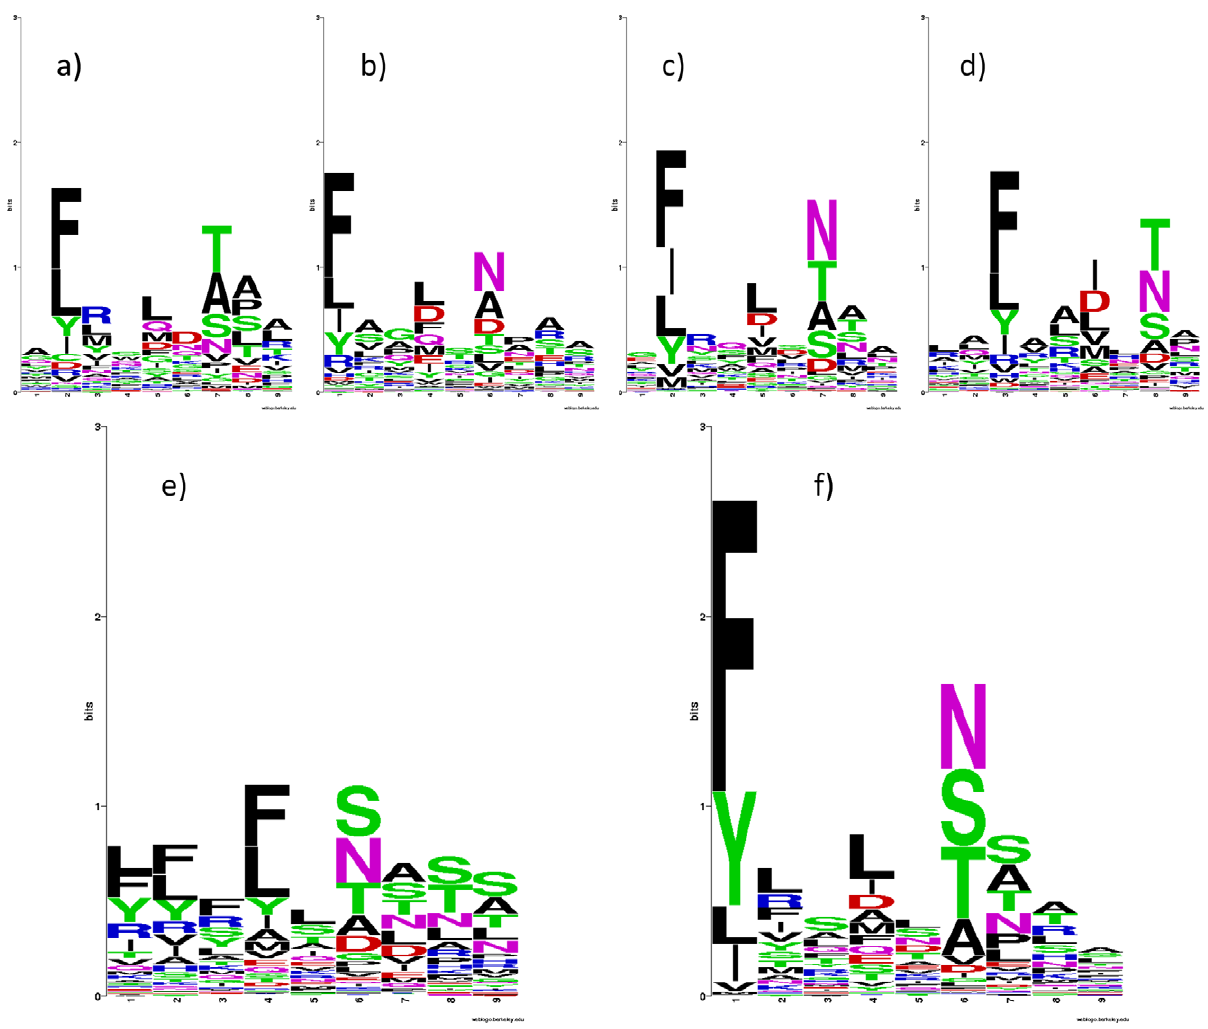
Figure 3. Sequence logos for HLA*DRB1-0401. In panels a) to d) are shown sequence logos for 4 single networks from the network ensemble created with NNAlign . The fundamental pattern appears in all these networks, but they place the anchors at different position of the core. e) shows the core of the 20 networks ensemble without offset correction; in f) offset correction was used to realign the logos to a common register.